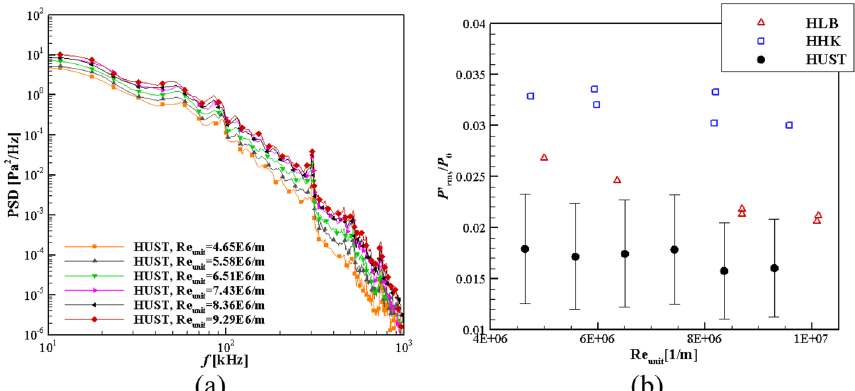
Fig. 6 Disturbance level characterization of the freestream. a PSD of Pitot pressure in the test section; b RMS of the normalized Pitot pressure fluctuation